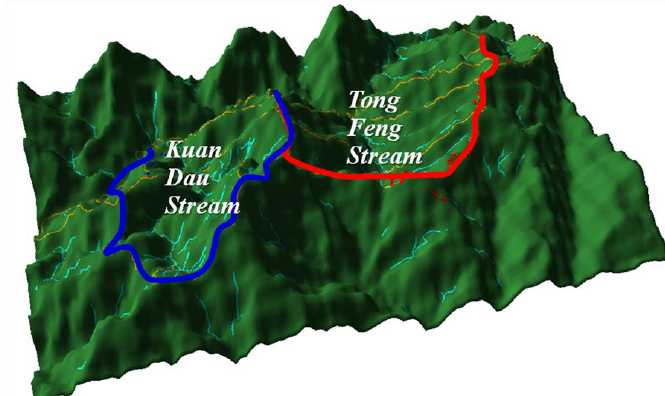
Table 4. The distribution statistics of three models predicting the potential habitat of CGTs